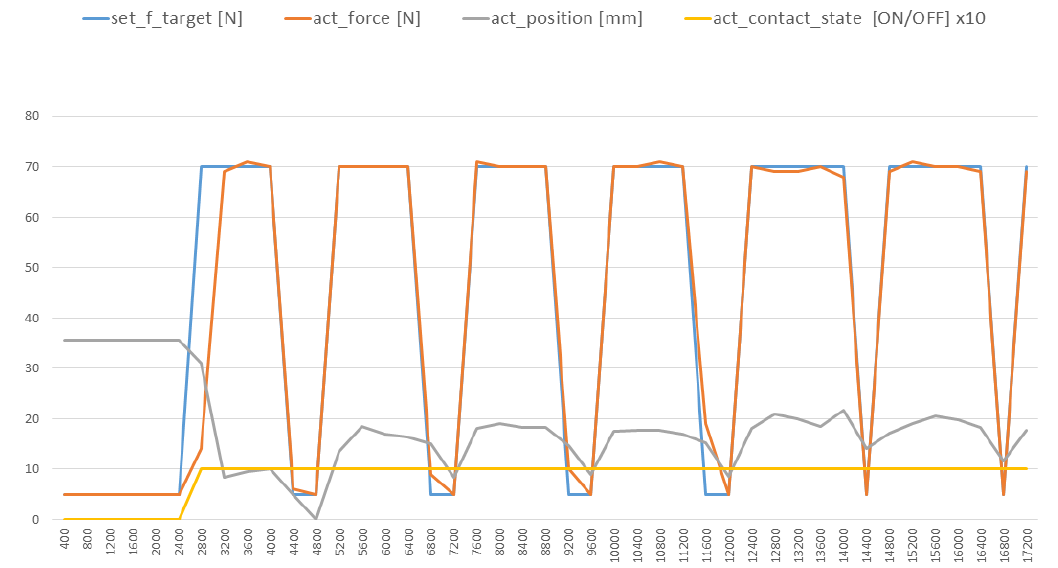
( a ) Showing results of the responsiveness of the robotic end-effector to desired forces of 60N and The yellow curve is actually binary (1 or 0) but we have multiplied it by a factor of 10 to show it clearly.